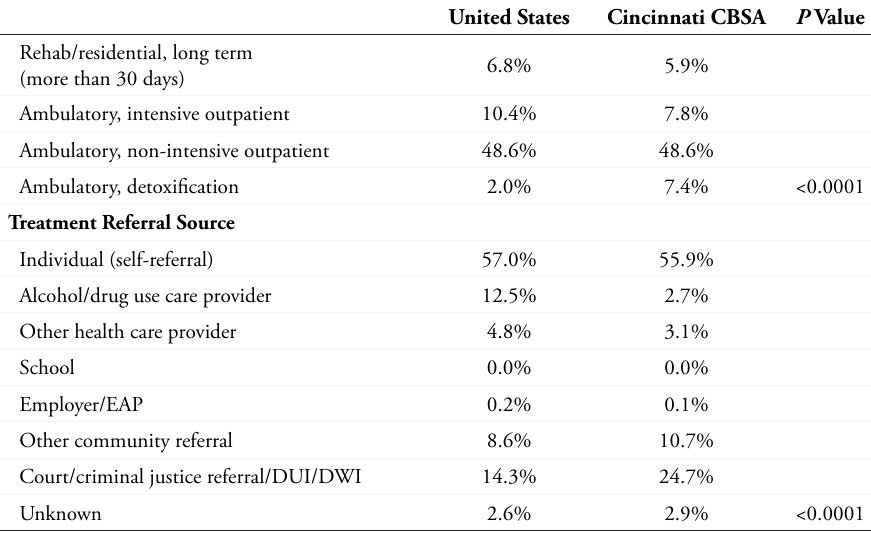
Table 1. Patient Characteristics by Cincinnati CBSA and the United States